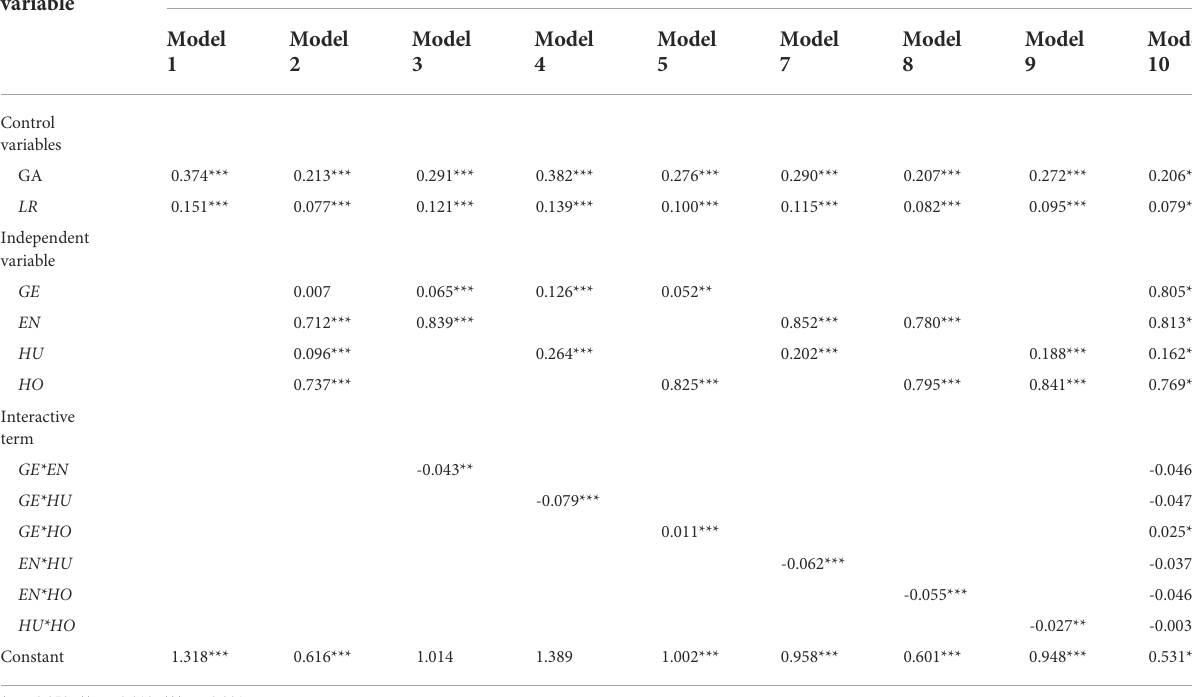
TABLE 9 Hierarchical multiple regression results.